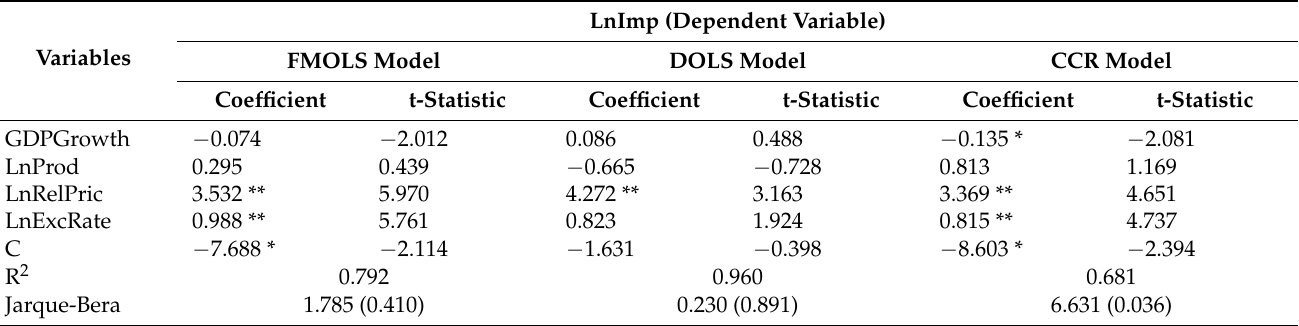
Table 9. Results of alternative approaches (dependent variable: lnImp).